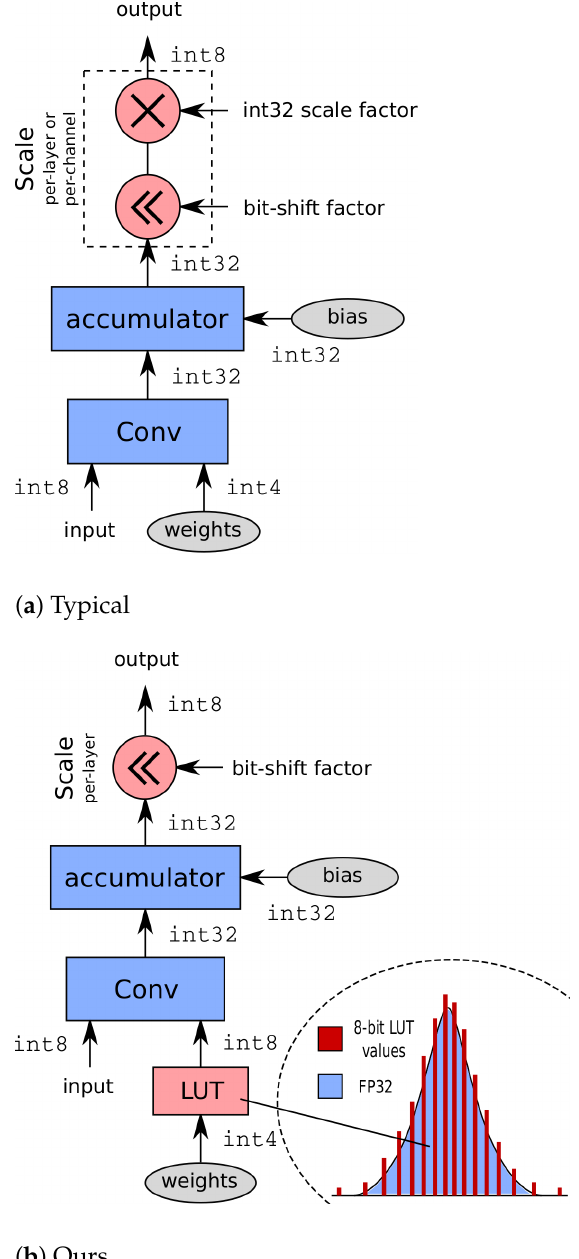
Figure 1. ( a ) Typical fixed-point compute engine of a convolutional layer; ( b ) our proposed fixed- point compute engine with a single per-layer power-of-two scale (bit-shift) and a lookup-table to translate 4 bit weights from storage to 8 bit weights for internal computation. The LUT is used to boost the expressive power of the engine through nonuniform weight quantization, which compensates the lack of high-precision